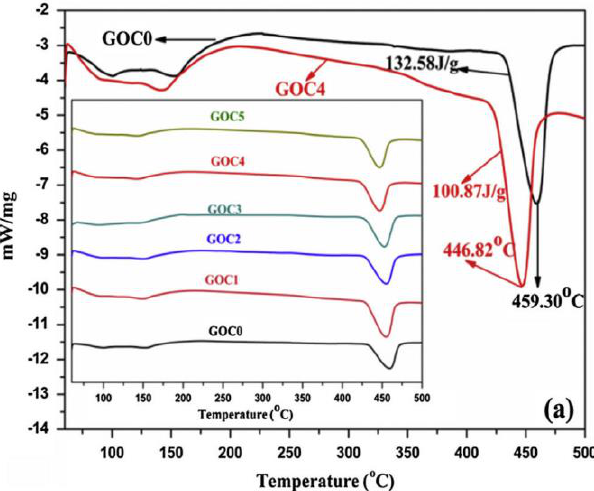
Figure 12. DSC curve of GO/cement composites at 28 days. Reprinted with permission from Ref. [96]. Copyright 2016 Elsevier.